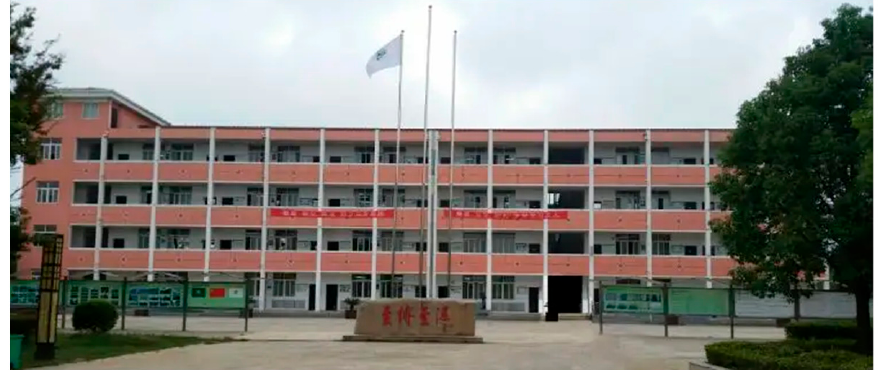
Figure 2. Donglu Middle